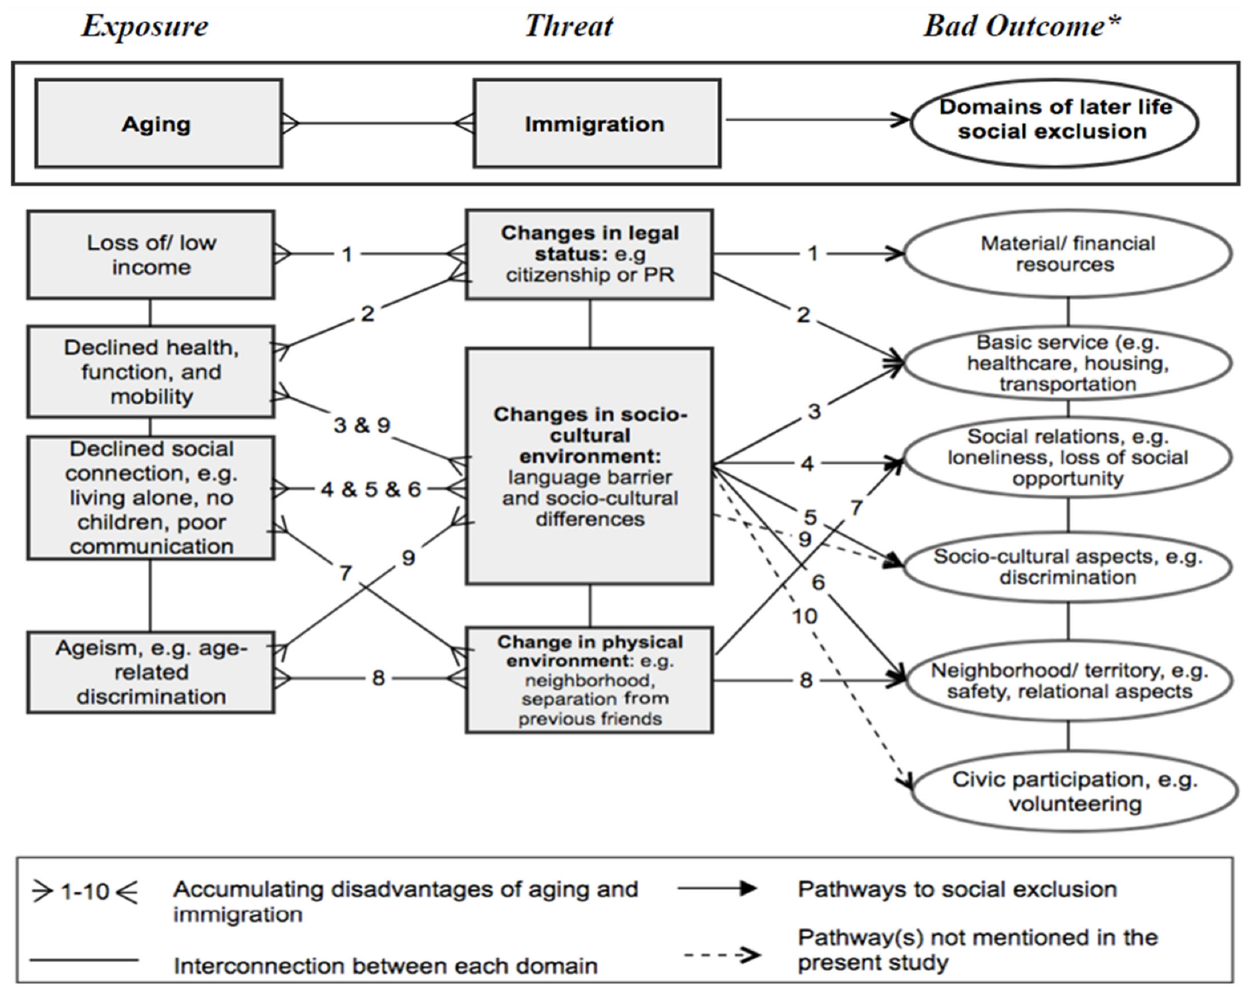
Figure 1. Pathways to social exclusion experienced by older Chinese immigrants. * Adaptation can be those positive approaches for achieving/maintaining social inclusion by avoiding social exclusion. Note: PR is permanent residence.